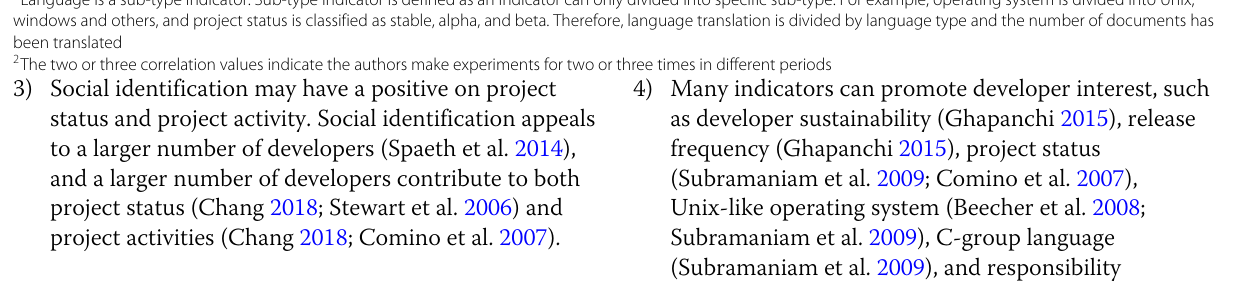
+ −→ B ” means A makes a positive impact on B ,